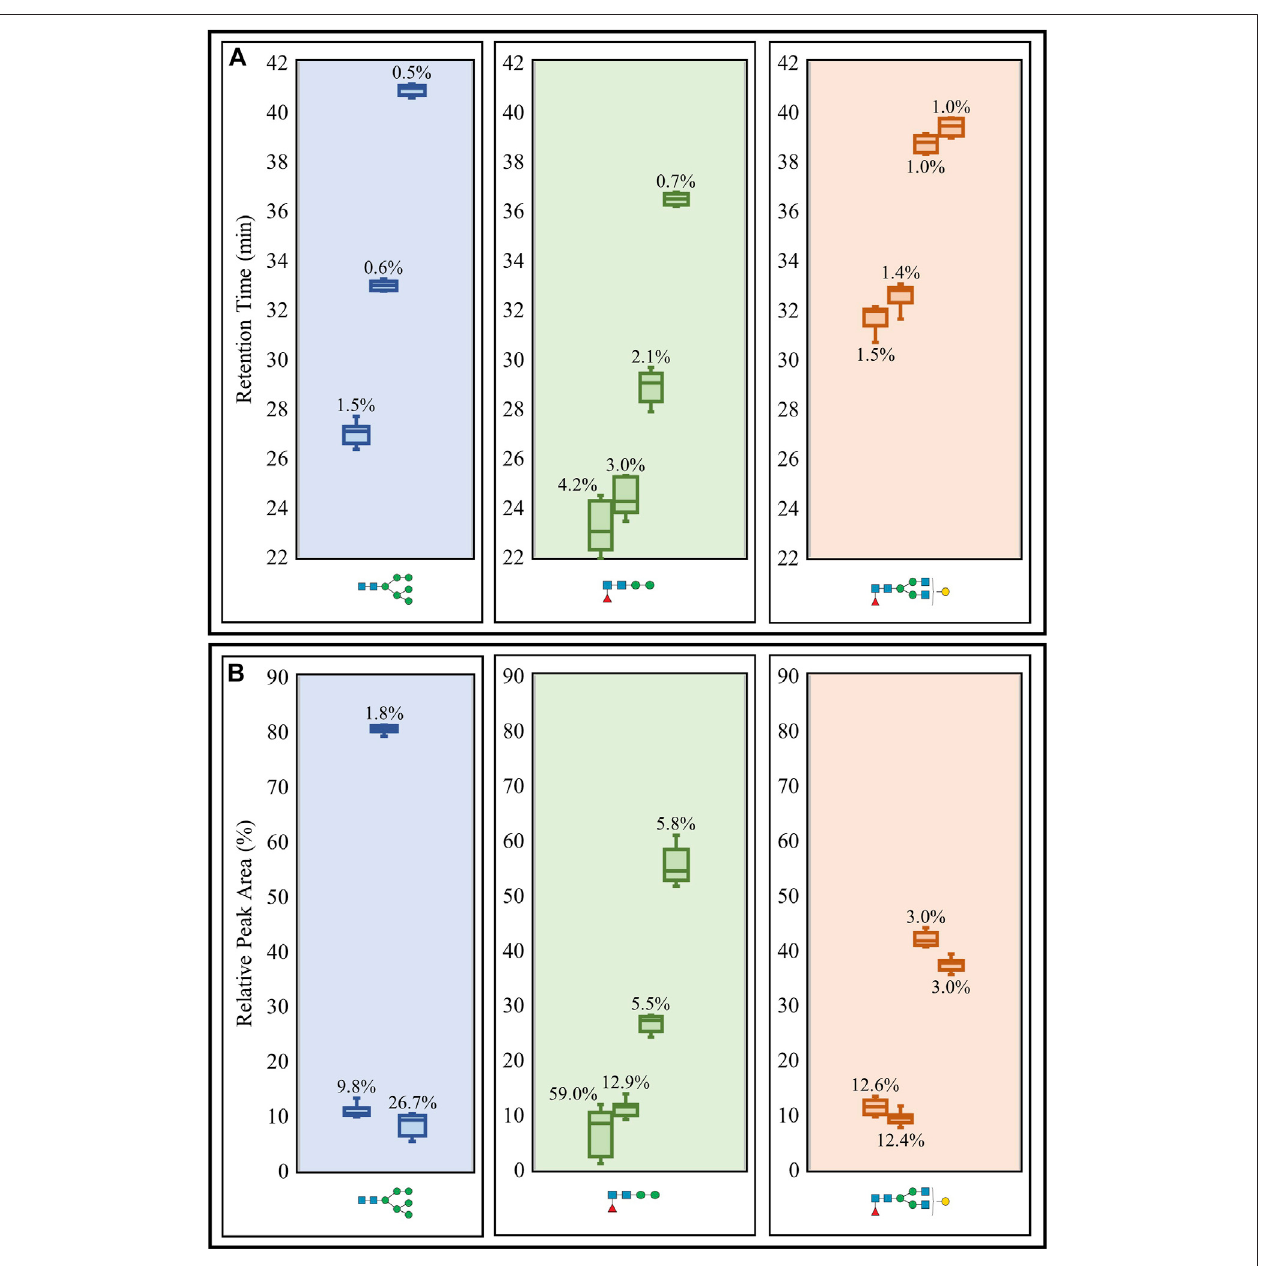
FIGURE3| Intermediateprecisionstudyofretentiontimes (A) andrelativepeakareas (B) ofthreerepresentative N- glycans(includingisomericstructures)released from the glycoprotein standard mixture. Box plots and CVs (annotated) were calculated for each N- glycan representative detected from triplicate PGC LC-MS runs performed over three days. Raw retention time data ( Supplementary Table S4 ) and raw relative peak area data ( Supplementary Table S5 ) are available.